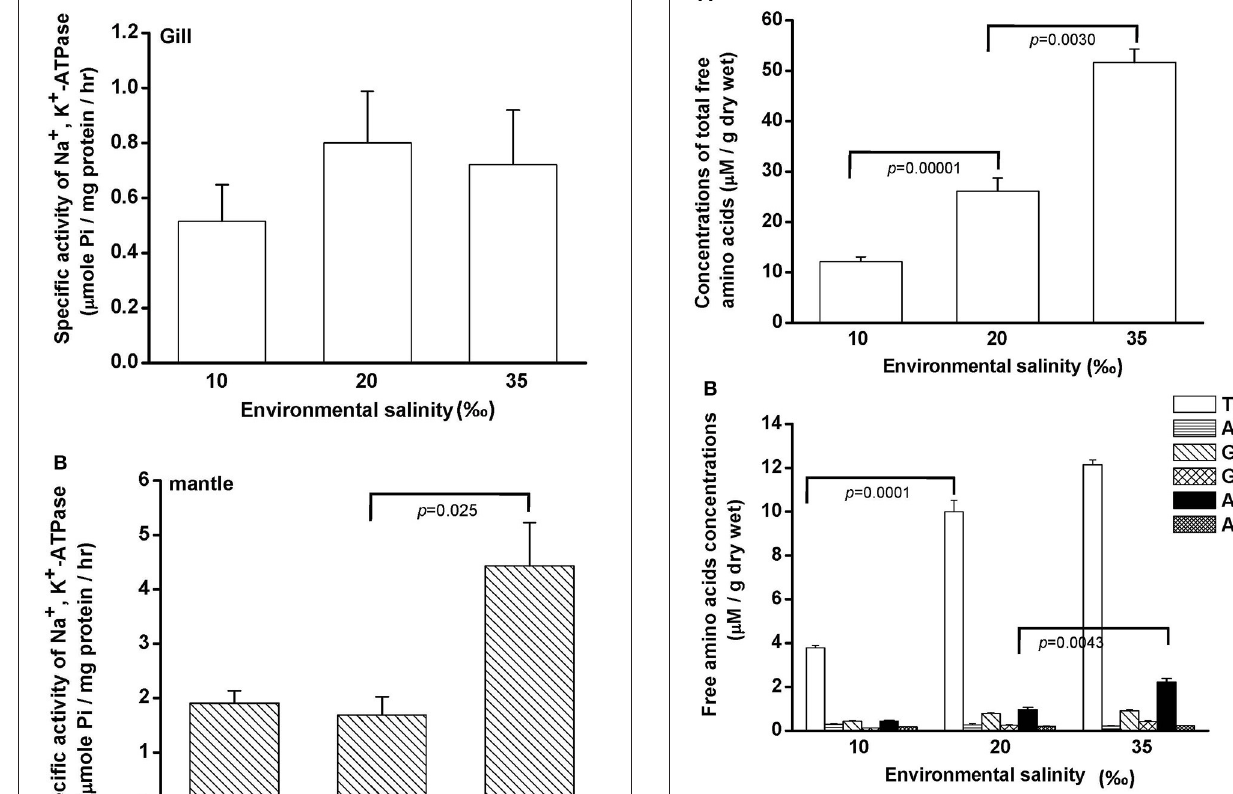
FIGURE 3 | Salinity effects on concentrations of total free amino acids (A) and different free amino acids (B) in gills of the hard clam. Statistical analysis was performed with one-way ANOVA followed by Dunnett’s test. The 20 ‰ SW group was used as a control. p < 0.05 was considered statistically significant. Values are means ± SEM. ( N = 8). Tau, taurine; Asp, aspartate; Glu, glutamate; Gly, glycine; Ala, alanine; Arg,